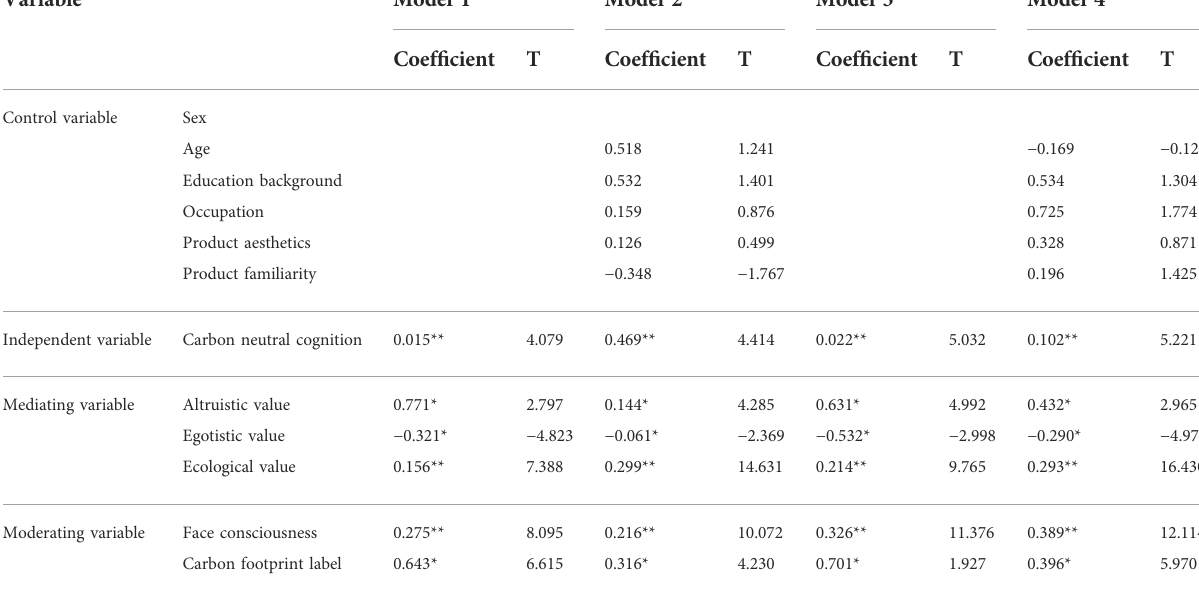
TABLE 5 Multivariate hierarchical regression results of the robustness test. Variable